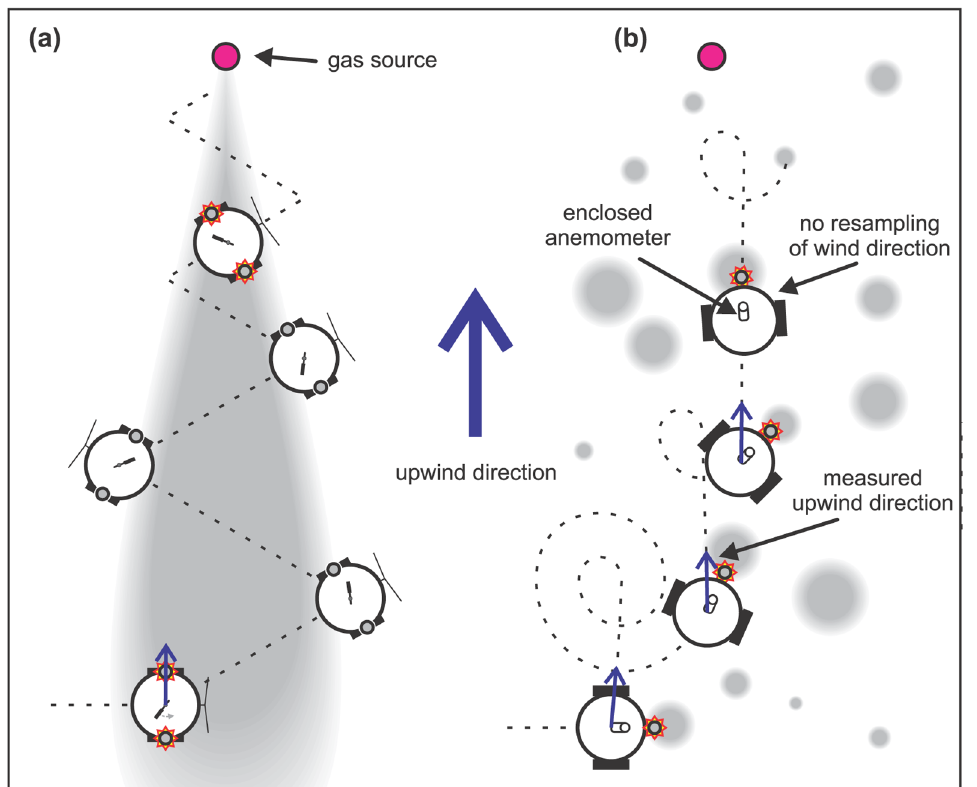
Figure 14 . (a) Dungbeetle G. stercorarius algorithm, Russell et al. [75]. (b) Spiral surge algorithm, Hayes et al.